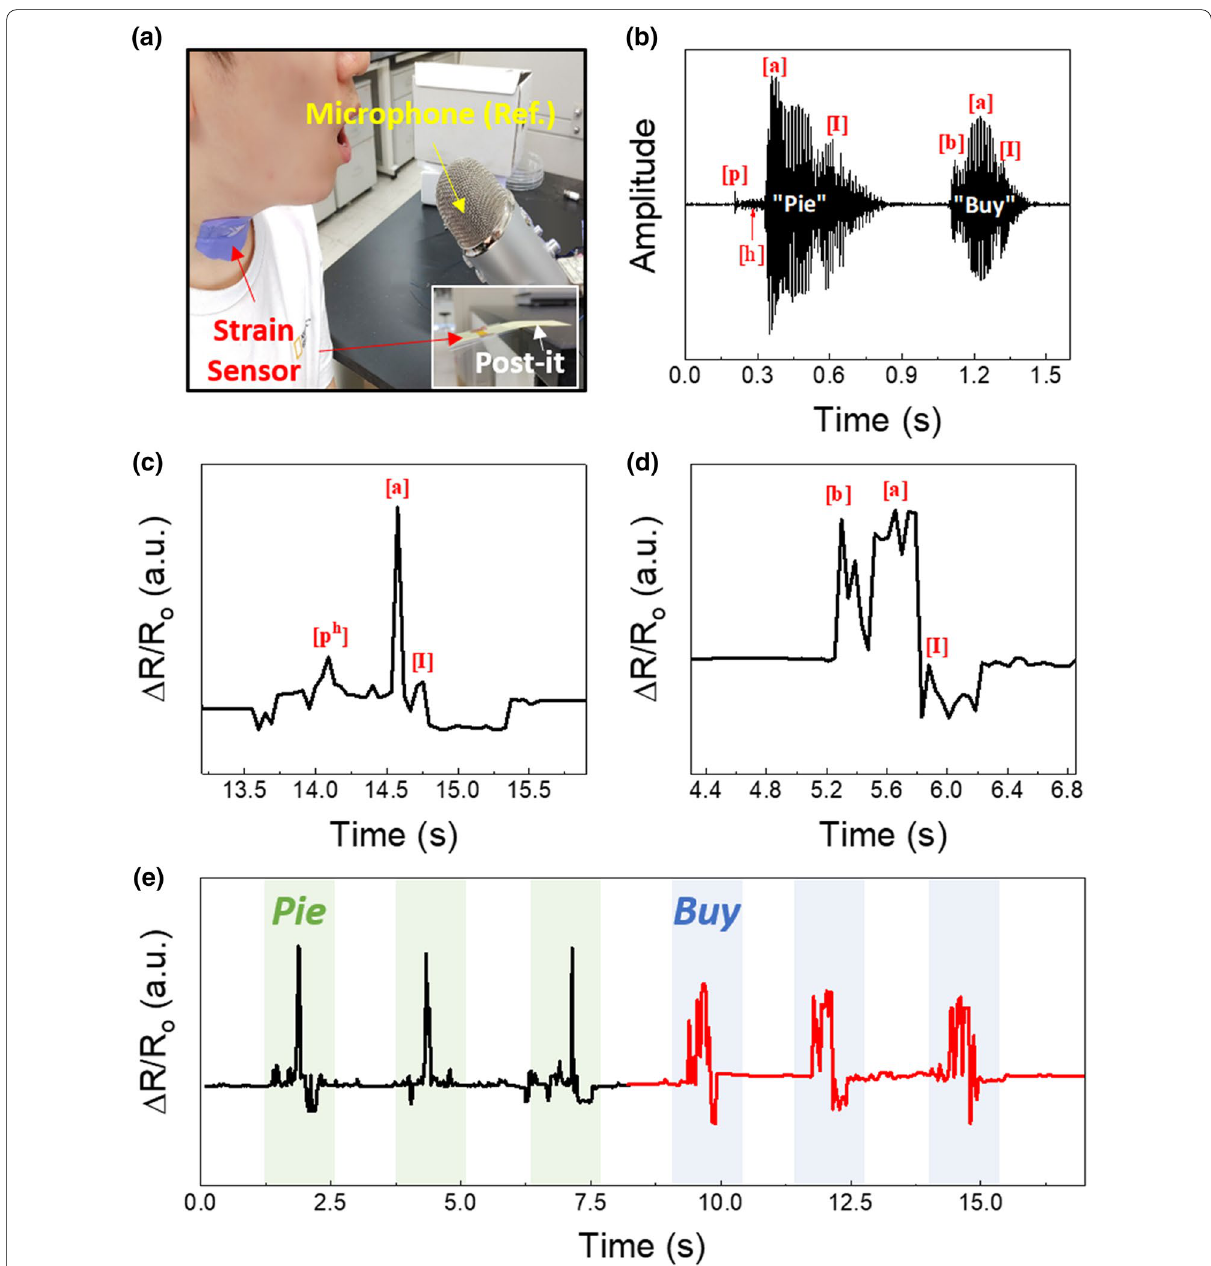
Fig. 5 a Photograph of the alternately printed Ag NC thin films attached to the neck of a speaker; inset shows a photograph of the strain sensors on a Post-it note. b Phonation waveforms of pie and buy recorded using a reference microphone. Changes in resistance of alternately printed Ag NC thin films attached to the neck for phonating c pie and d buy . e Repetition test for productions of pie and